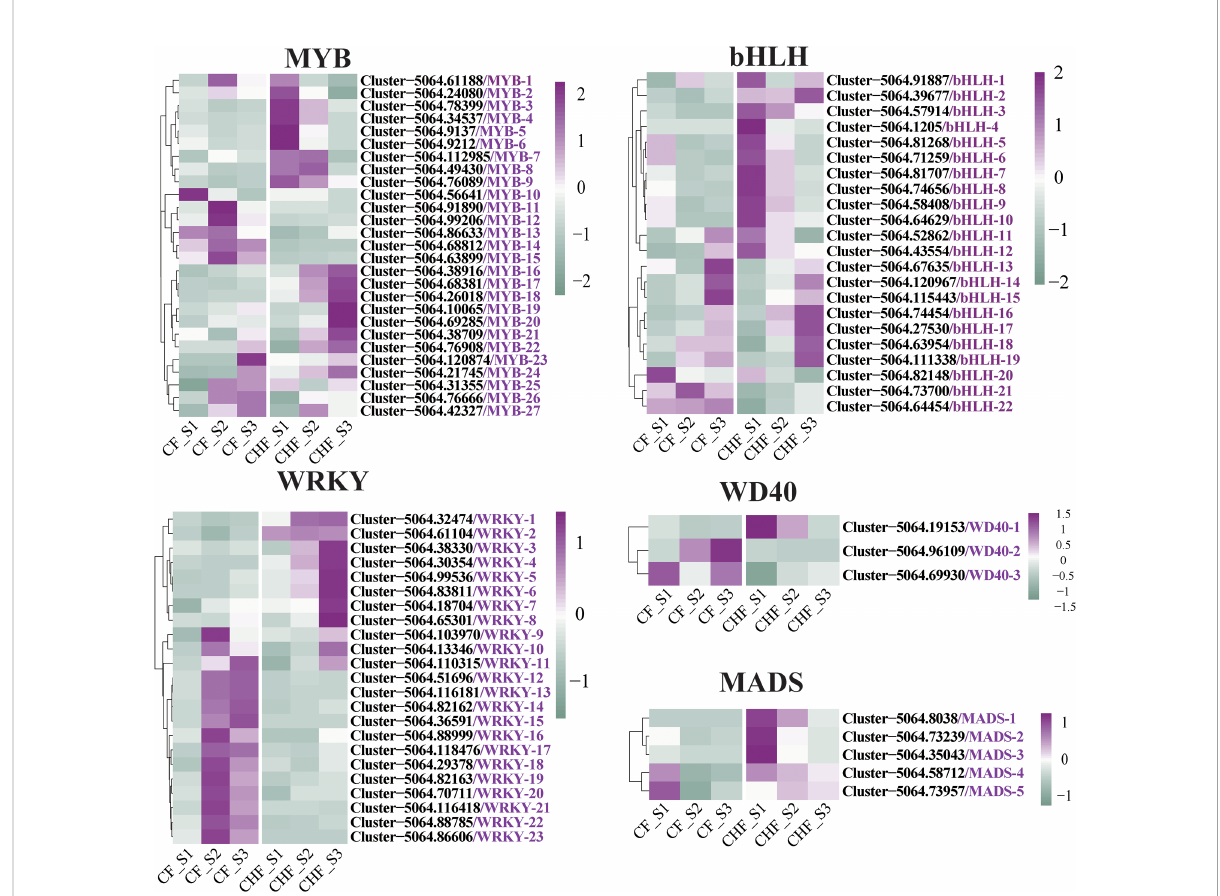
FIGURE 6 Screening of transcription factor family regulators differentially expressed in CF and CHF. Among them are WRKY, MYB, bHLH, WD40, and